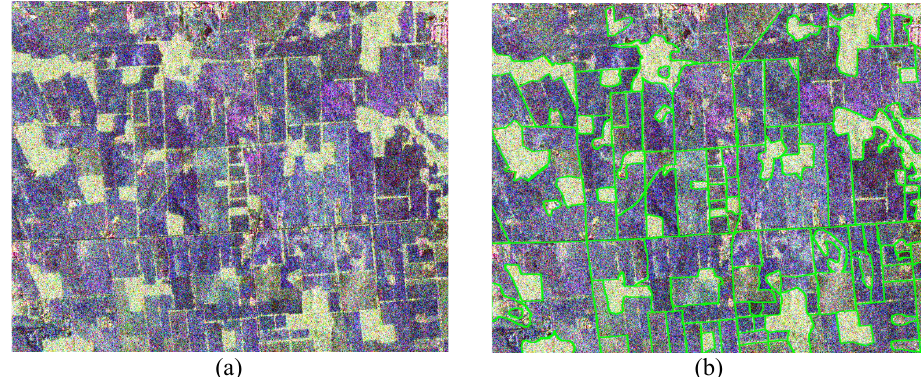
Figure 7. RADARSAT-2 data set. ( a ) Pauli-RGB image. ( b ) Ground-truth